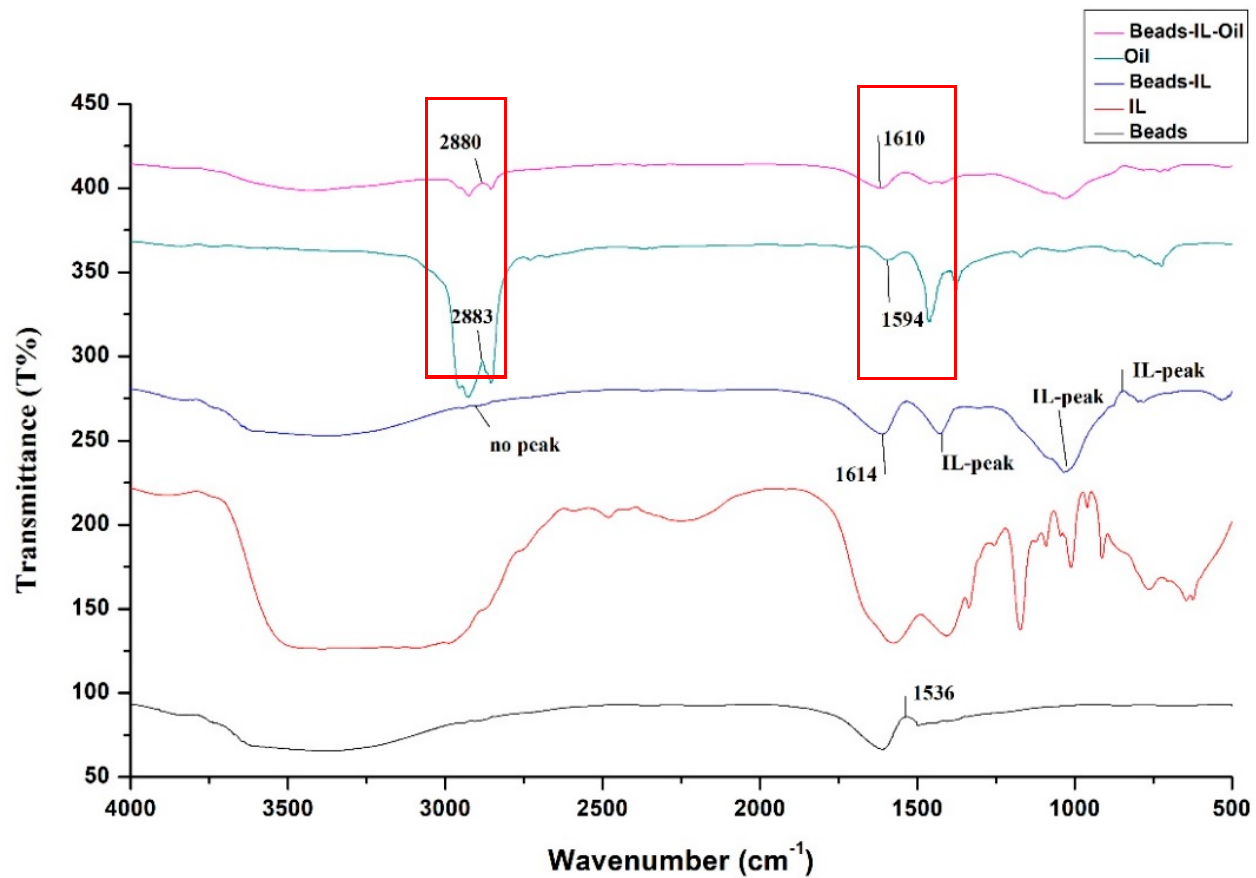
Figure 1. FTIR analysis before and after the adsorption of oil onto the surface of the beads.